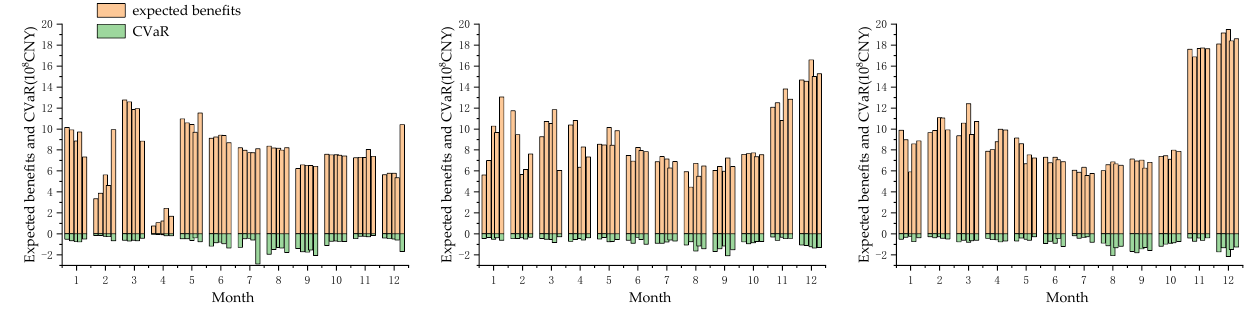
Figure 8. Expected benefits and CVaR of cascade reservoirs in schemes 1 to 15.